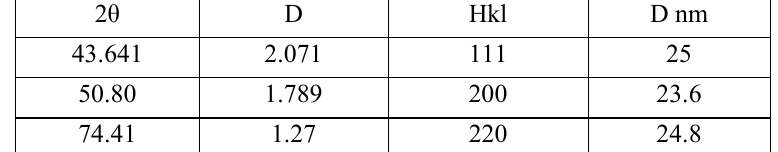
Table 1: The results of x-ray diffraction method for Cu PLALP